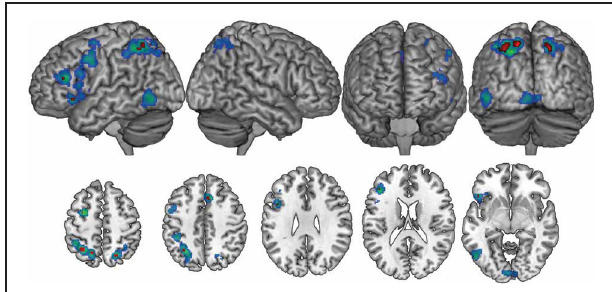
FIGURE 1 | The general imagery network (cool colors) was primarily left-lateralized, with bilateral activations in superior parietal regions. A conjunction analysis of studies employing complex and resting state baselines found nine clusters (red) within the general imagery network that were active across all imagery conditions, regardless of baseline